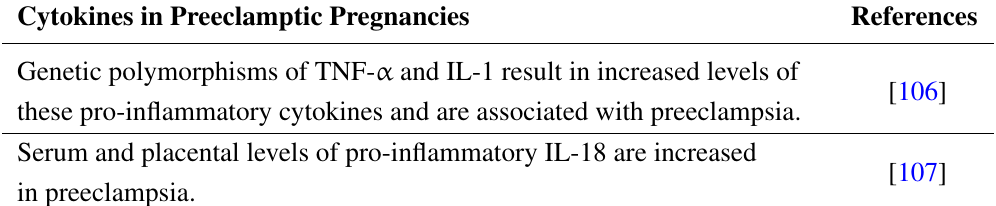
Table 1. Inflammatory cytokines in